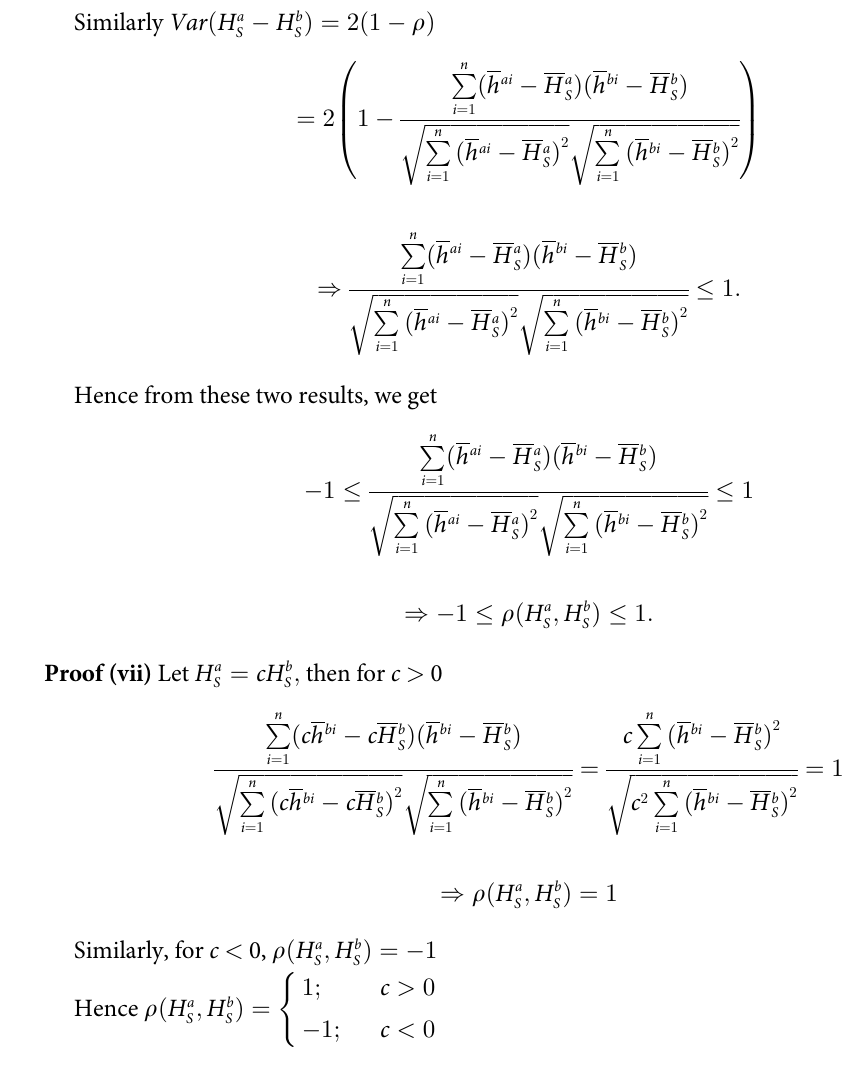
ffiffiffiffiffiffiffiffiffiffiffiffiffiffiffiffiffiffiffiffiffiffiffiffiffiffiffiffi P n